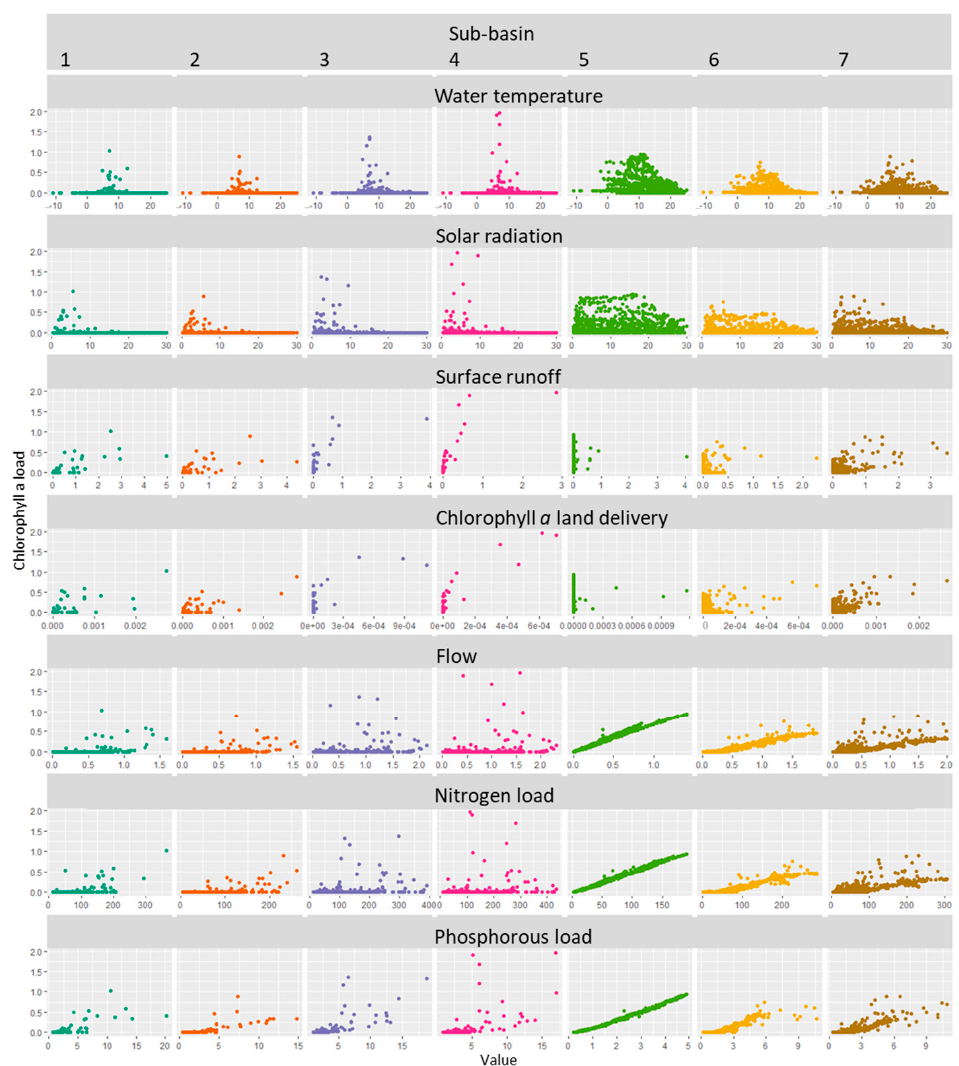
Figure 4. Chlorophyll a and the selected parameters relationship plots for each sub-basin separately. A detailed analysis of the correlation of chlorophyll a load and the studied parameters for individual sub-basins is presented in Table 1, while the relationships for all parameters are included as correlation matrices in Supporting Information